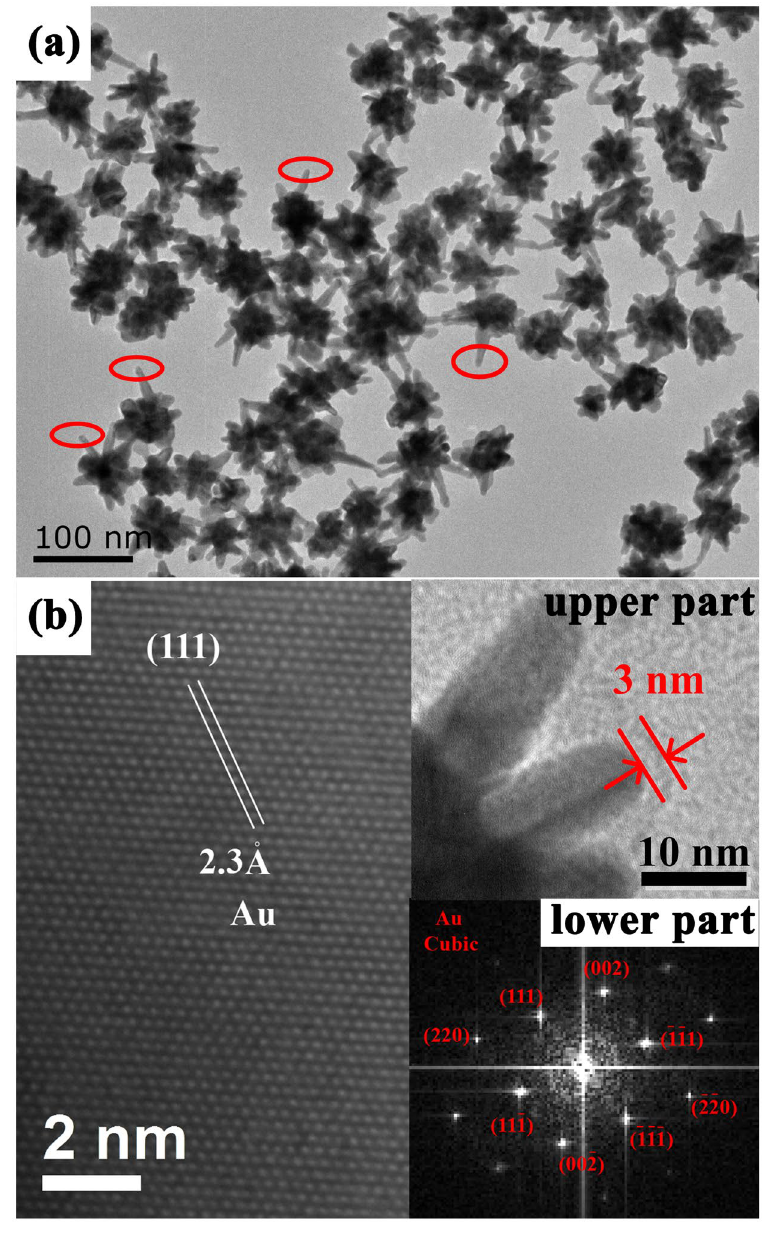
Figure 1. ( a ) TEM image of GNSs with AgNO 3 concentration of 30 mM. ( b ) HRTEM image of GNS. The inset of bottom is the corresponding FFT pattern of the